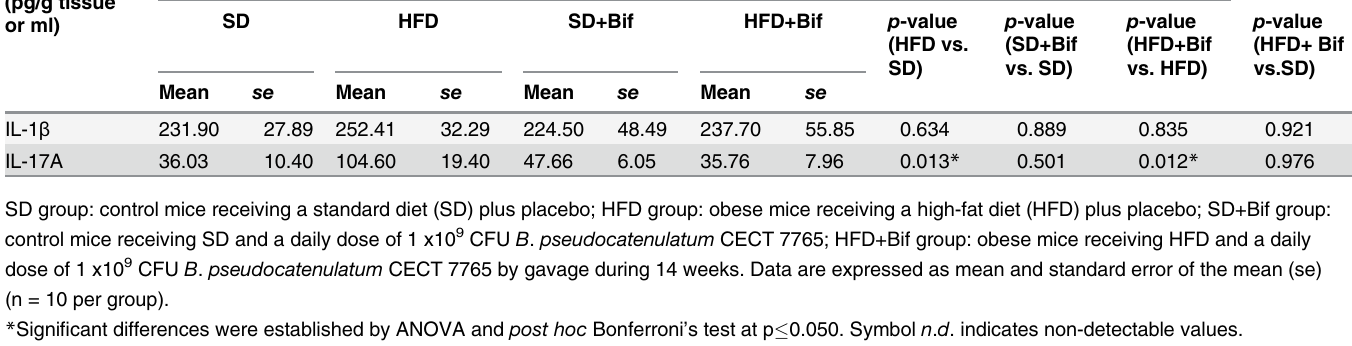
and between the two groups fed the HFD (HFD group and HFD+Bif group) (Fig 8, Table in S3 File). On phylum level, Firmicutes dominated the microbiota of the SD group and the SD+Bif group representing 65 and 66% of all reads, respectively, followed by Bacteroidetes, which rep- resented 31% (Table in S3 File). In the microbiota of both HFD-fed mouse groups, Firmicutes were significantly increased ( p < 0.001 for both comparisons, SD versus HFD group and SD+Bif versus HFD+Bif group), while Bacteroidetes were reduced ( p < 0.001 for both comparisons). Additionally, HFD feeding increased the proportion of Proteobacteria compared to SD feeding ( p < 0.001 for both comparisons). On family level, Porphyromonadaceae showed significantly lower abundance in both HFD- fed mouse groups (HFD and HFD+Bif) than in both SD-fed mouse groups (SD and SD+Bif)